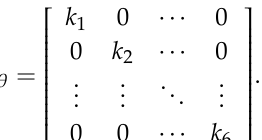
Table 1. Denavit–Hartenberg (DHm) parameters of the robot in the research case.